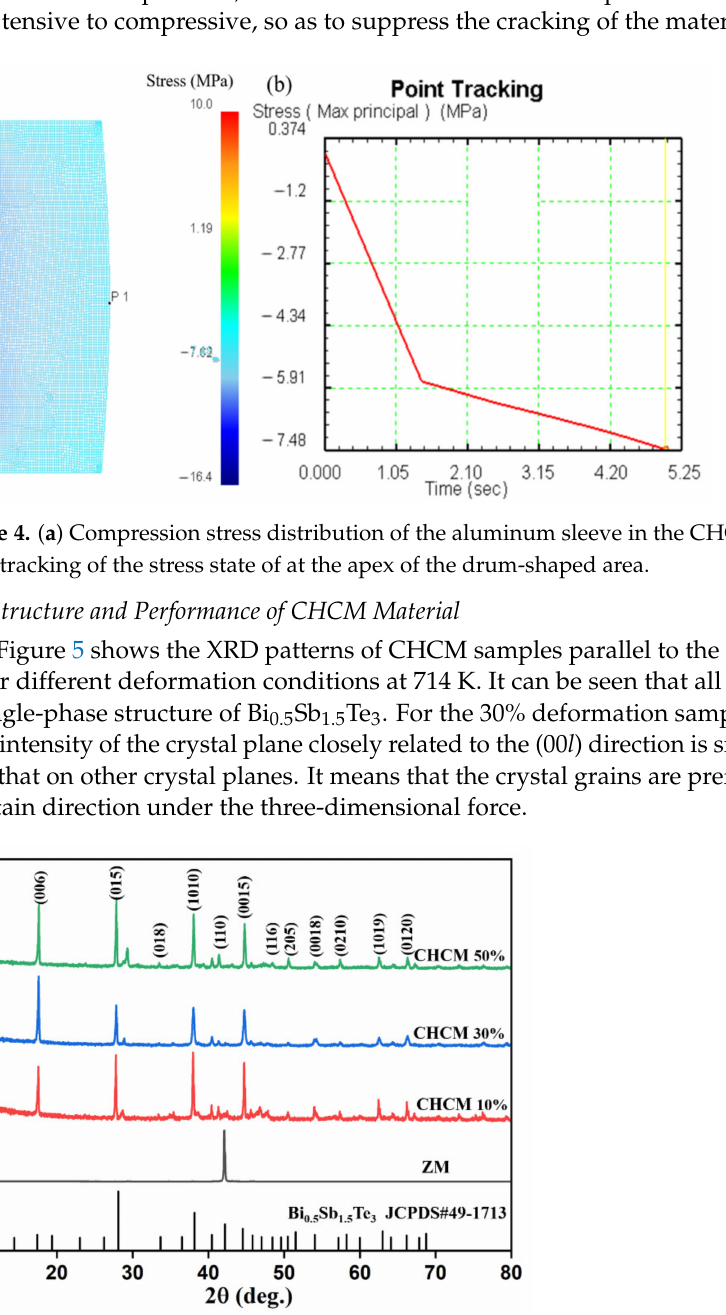
Figure 5. XRD patterns of Bi 0.5 Sb 1.5 Te 3 samples by ZM and CHCM under different